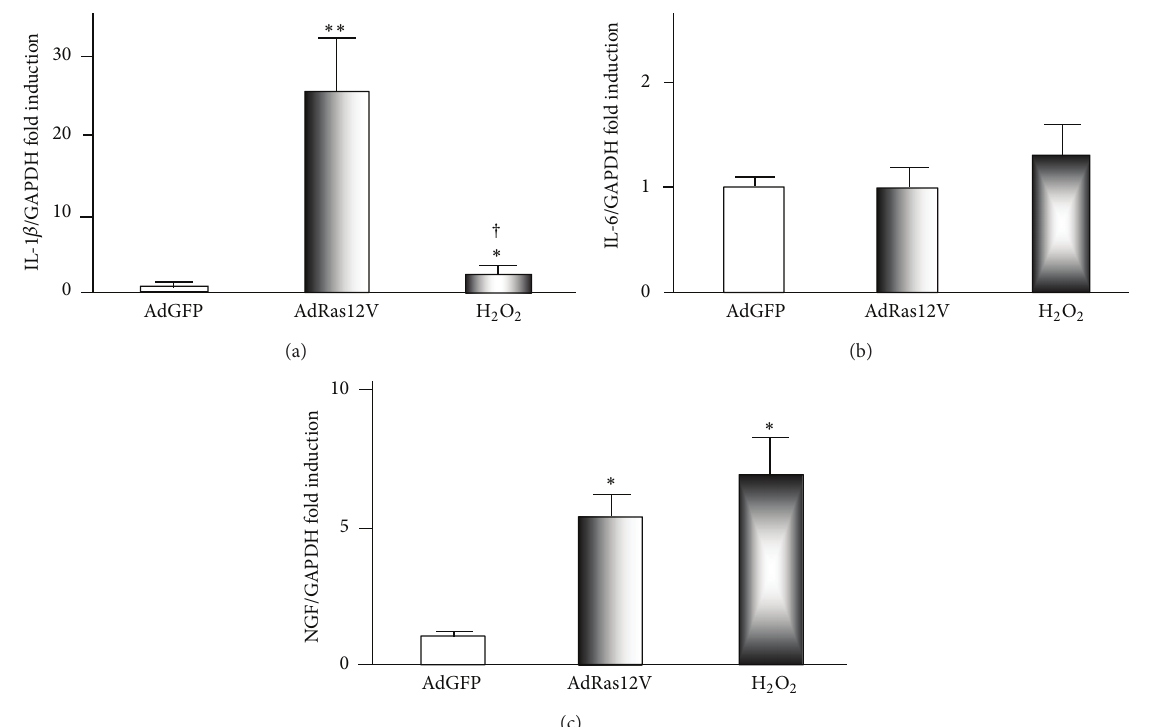
Figure 3: Real time PCR analysis of the expression of proinflammatory cytokines in HUVECs. HUVECs were infected with AdGFP or AdRas12V or treated with 100 𝜇 mol/L H 2 O 2 . After 1 week, total RNA was extracted for real time PCR analysis. The expression of IL1- 𝛽 , IL-6, and NGF was normalized to GAPDH. ∗ and ∗∗ : 𝑃 < 0.05 and 𝑃 < 0.01 , respectively, versus AdGFP infection. † : 𝑃 < 0.01 versus AdRas12V infection ( 𝑛 = 6 per